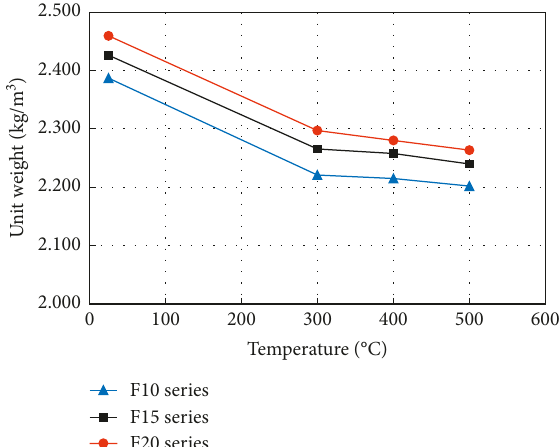
Figure 8: Comparison of unit weights before and after six thermal cycles.